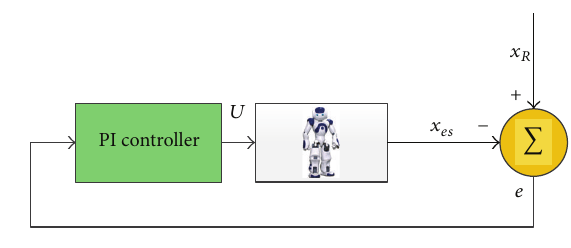
Figure 3: The closed-loop controller.